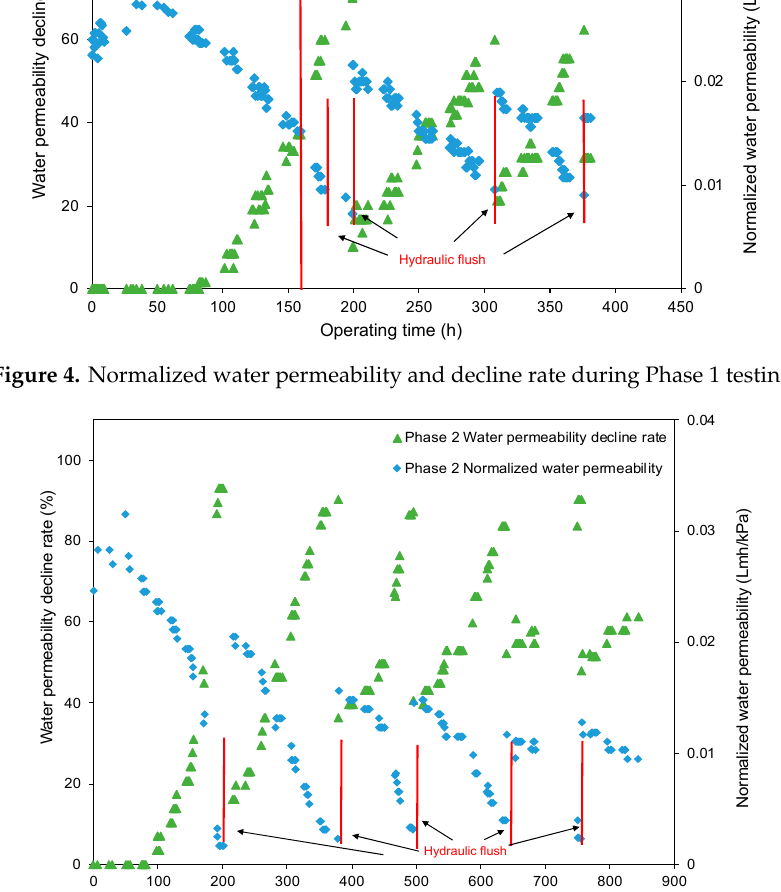
Figure 5. Normalized water permeability and decline rate during Phase 2 testing with EMF.